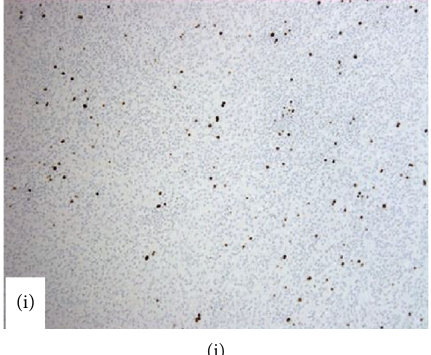
Figure 3: Legend: H&E section (a: 4X) and (b: 10X) showing schwannoma, with interspersed small lymphoid aggregates and a plasma cell in fi ltrate on the right. (c) S-100 showing di ff use and strong, cytoplasmic, and nuclear positivity in the schwannoma component on the left (10x). (d) CD138 immunostain (10x) showing plasma cells in fi ltrating into the schwannoma. In situ hybridization studies for kappa (e) and lambda (f) light chains (10x) show that the plasma cells are kappa-restricted. (g) CD3 (10x) highlights T cells scattered interstitially and within the lymphoid aggregates. (h) CD20 (10X) highlights few scattered B cells. (i) Ki-67 (10x) shows very low proliferative